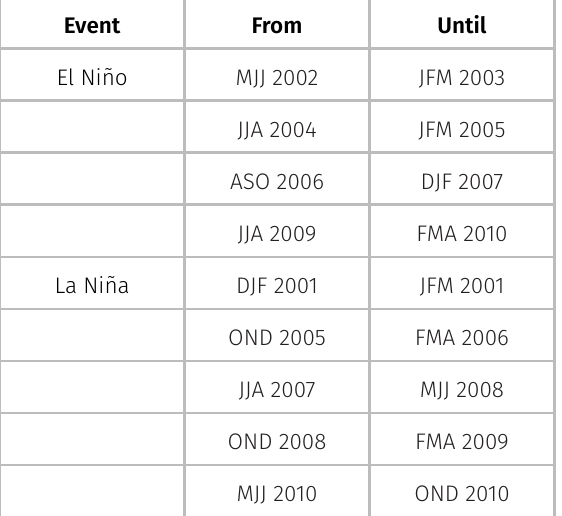
Table I. List of El Niño and La Niña events from 2001 until 2010 (source: NOAA CPC website). Event From Until El